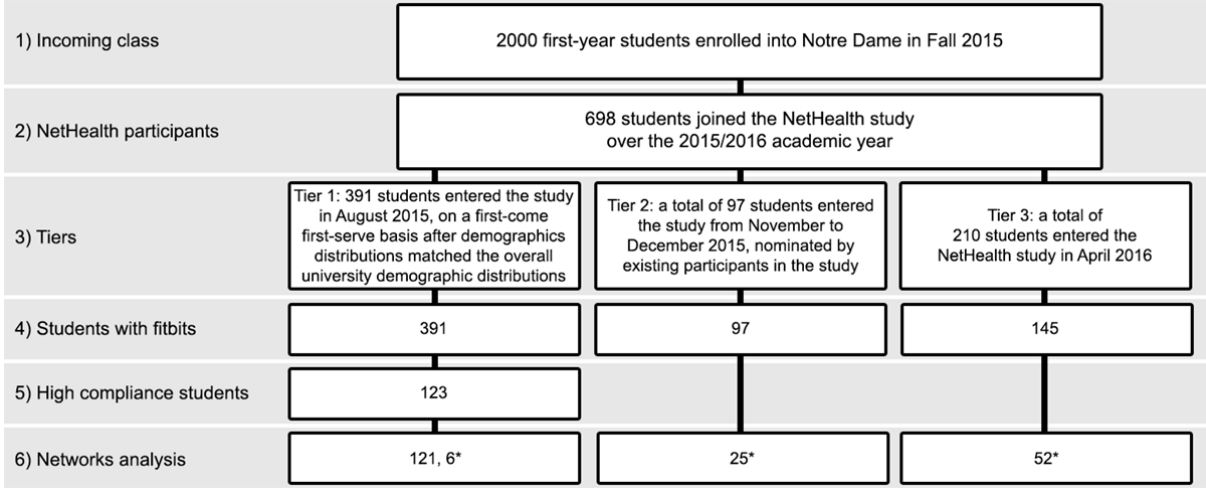
Figure 1. Consort diagram of NetHealth recruitment and participants selected for this analysis in this paper. Asterisks indicate participants added as additional alters for the ego-network analysis in case study 2.